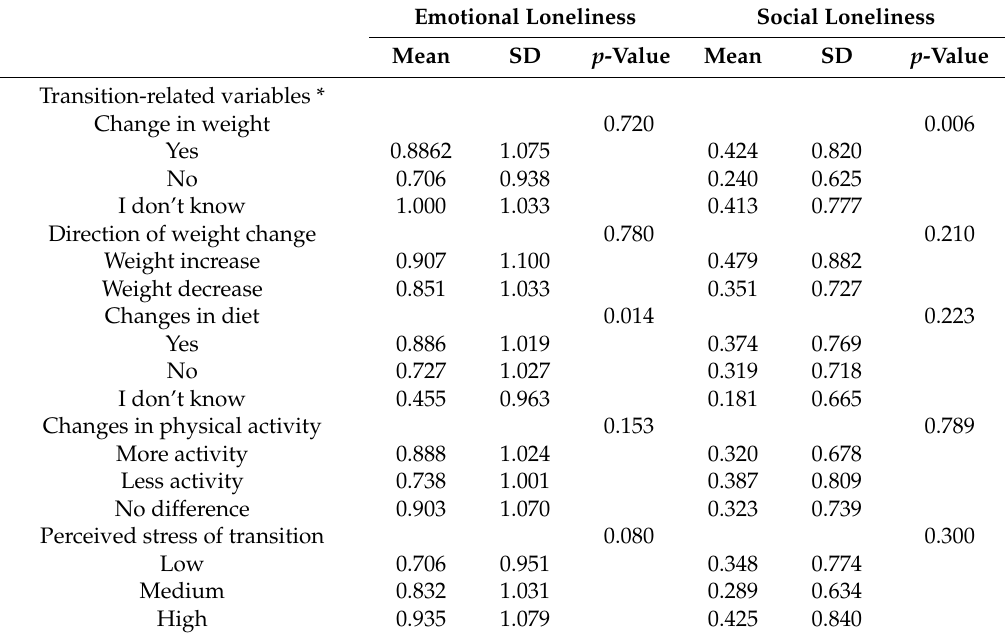
Table 6. Emotional and social loneliness by transition-related variables in university students in